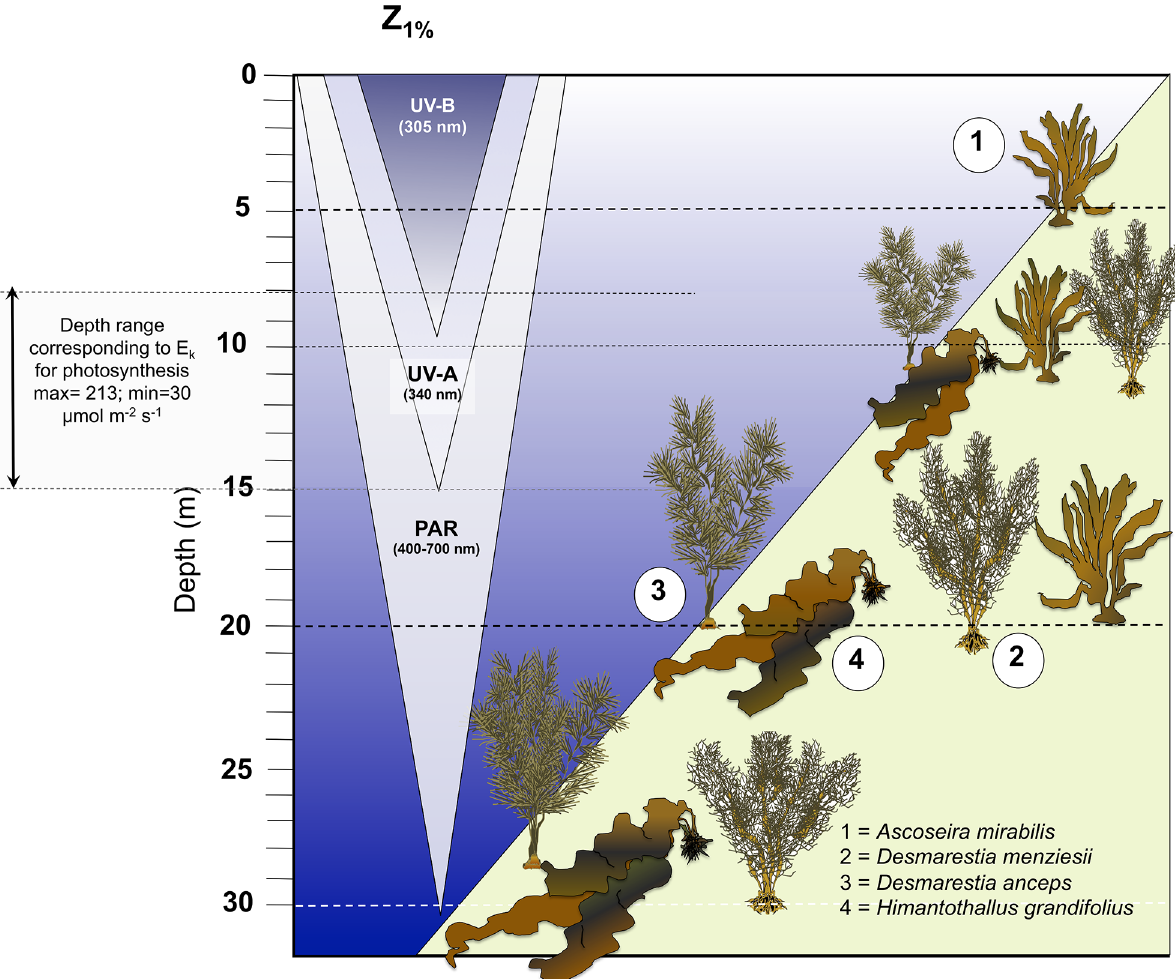
Fig 1. Scheme of the vertical distribution of the studied Antarctic macroalgae coexisting at King George Island indicating the summer light field scenario of relevant solar radiation wavelengths and depth ranges for saturation of photosynthesis (E k ).